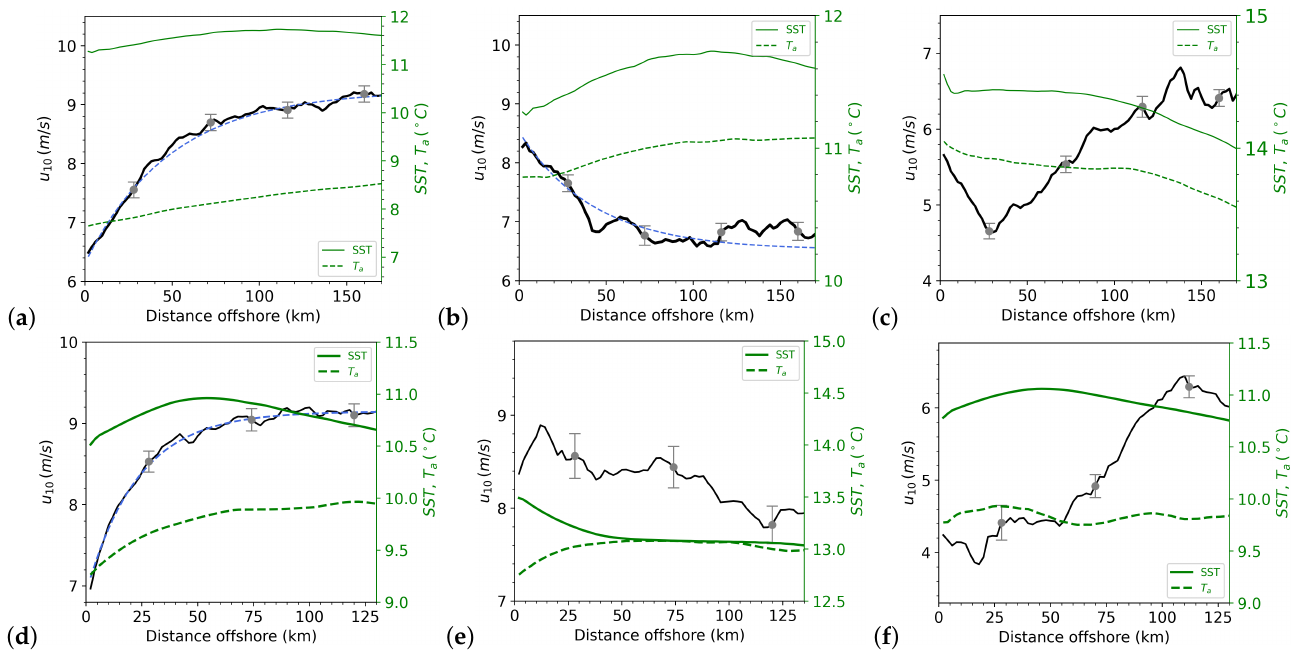
Figure 10. ( a – c ): Mean wind speed gradients for classes “INCS” ( a ), “DECS” ( b ) and “LINCS” ( c ) for easterly winds. Air and sea surface temperatures from DWD are, respectively, shown as dashed and solid green lines. ( d – f ): The same as ( a – c ), but for southerly winds. The blue and orange dashed lines in ( a , b , d ) refer to the fitted empirical